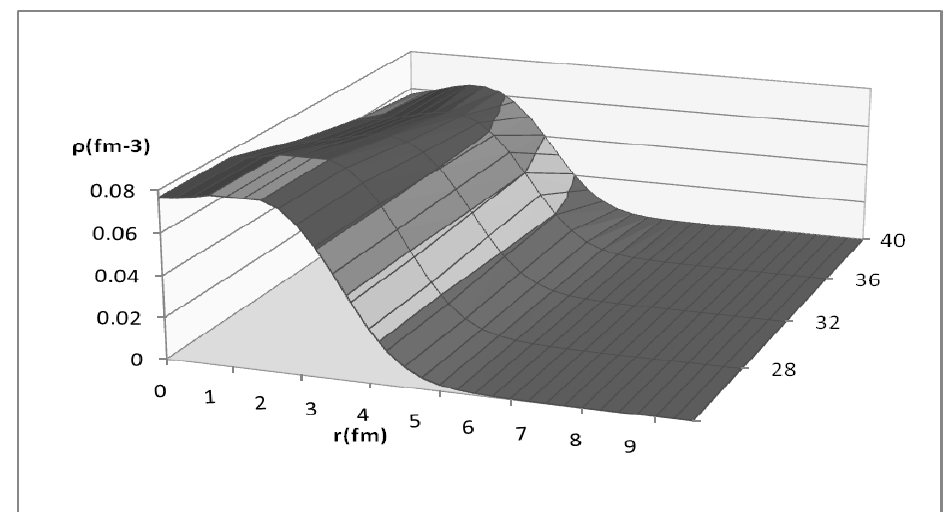
Fig. 5: Charge density variation with mass number from SkX parameterization for different Si- isotopes.